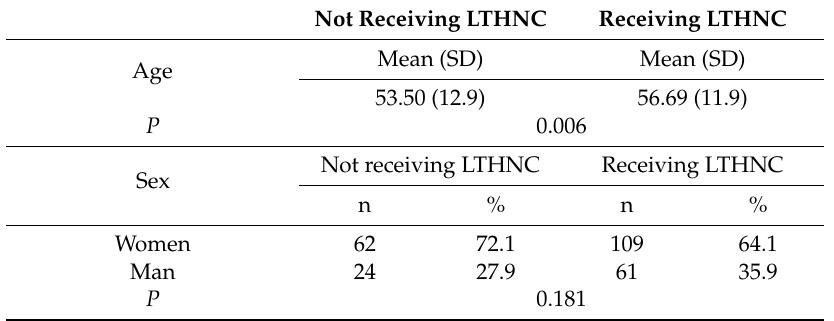
Table 1. Characteristics of caregivers of patients not receiving Long-Term Home Nursing Care (LTHNC) and receiving